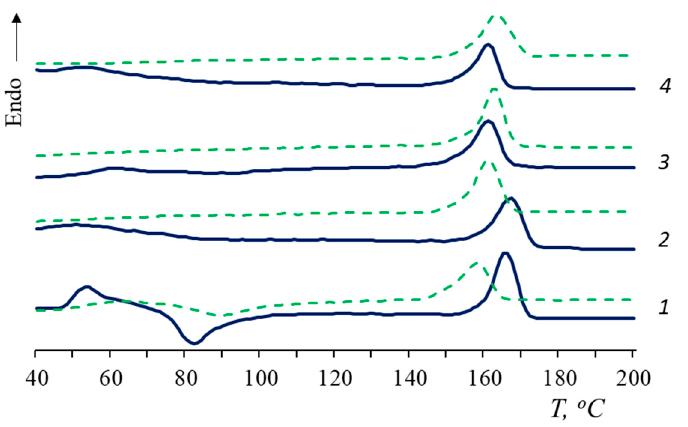
Figure 5. Melting thermograms of PLA/NR films. The content of NR, wt.%: (1) 0; (2) 5; (3) 10;.(4) 15. Blue: initial samples; green: after hydrolytic degradation.